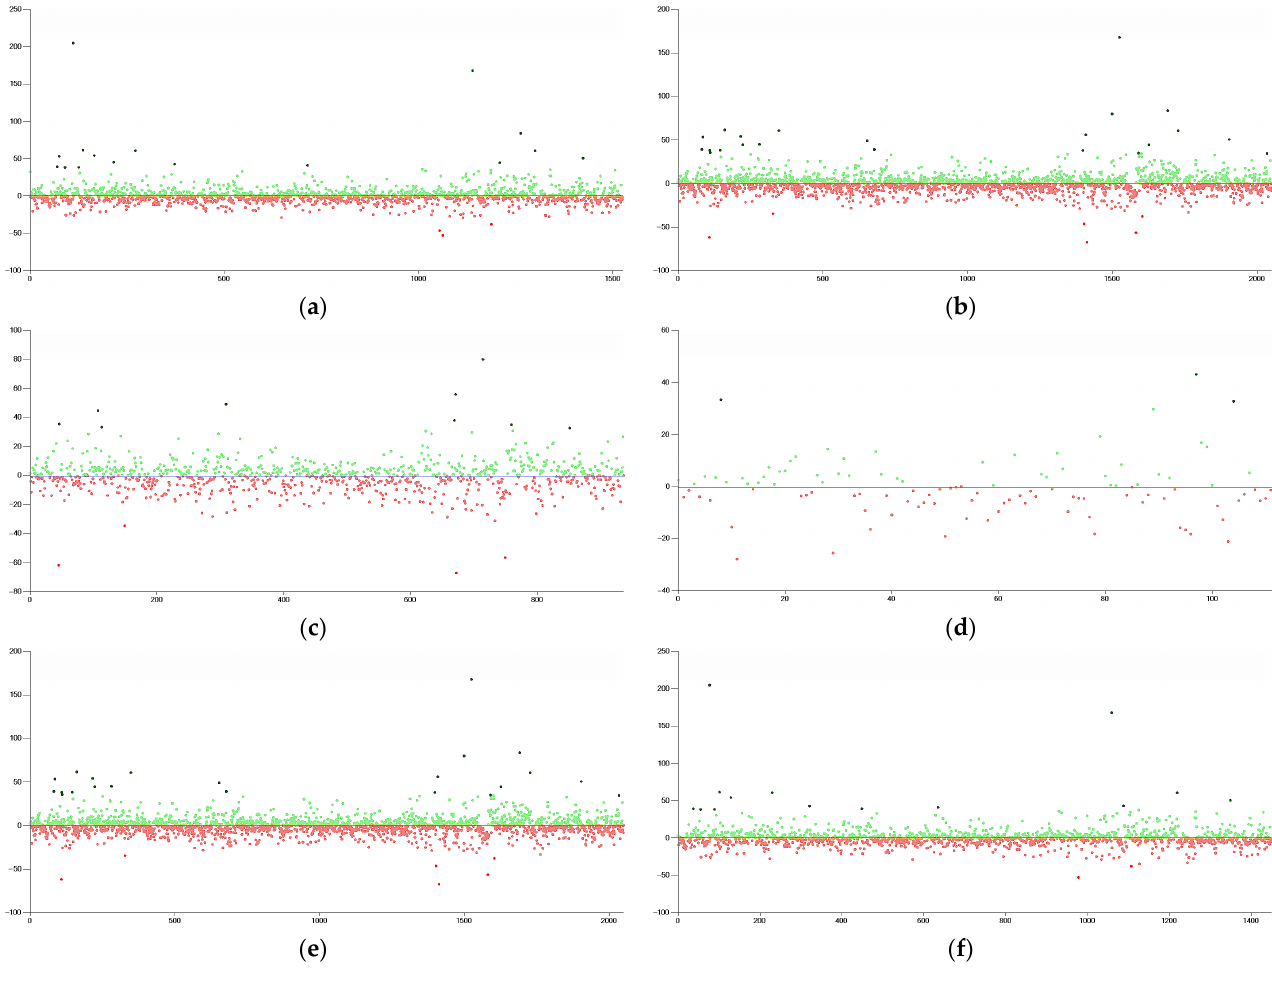
Figure 3. Stability of technical trading systems for the period 1 July 2012 to 30 June 2022 for each component stock. Green (red) indicates profit (loss) trades. The y-axis represents percentage returns for each trade, while the x-axis shows the trade number over time. ( a ) MACD; ( b ) D-MACD; ( c ) BB; ( d ) D-BB; ( e ) MACD-BB; ( f )